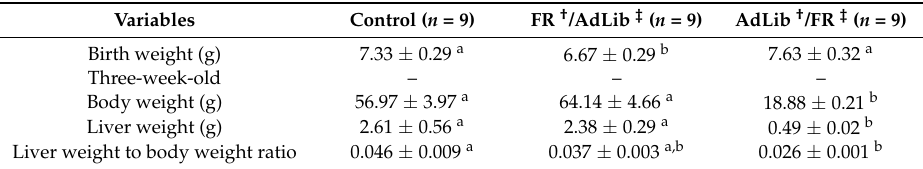
Table 1. Comparison of body and liver weights in male offspring of dams fed ad libitum (AdLib) or food restriction (FR) diets during pregnancy and lactation.